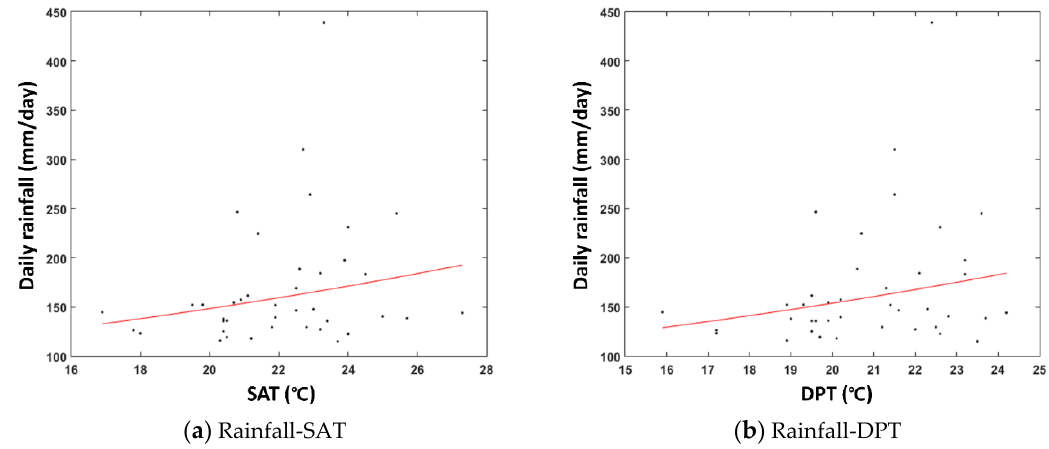
Figure 5. Sensitivity of annual exceedance daily rainfall depth at Busan site.